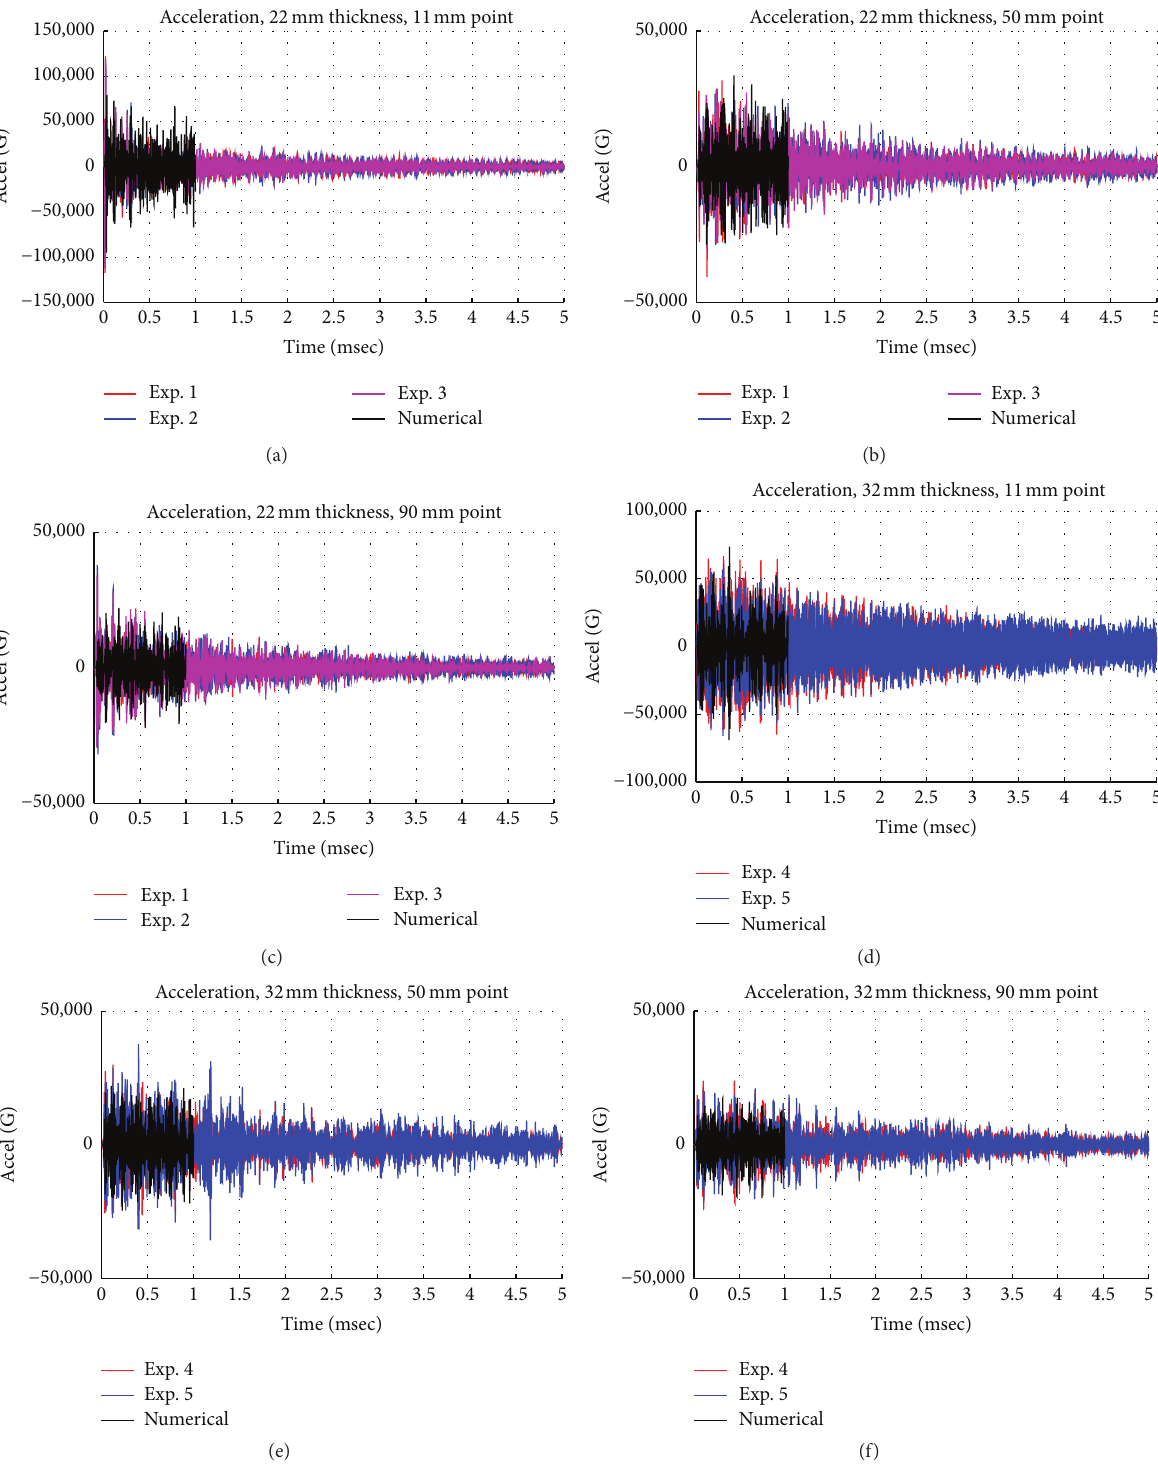
Figure 11: Comparison of acceleration between the numerical analysis and the experiments: (a) 11mm point at a 22mm thickness circular plate, (b) 50 mm point at a 22 mm thickness circular plate, (c) 90 mm point at a 22 mm thickness circular plate, (d) 11mm point at a 32 mm thickness circular plate, (e) 50 mm point at a 32 mm thickness circular plate, and (f) 90mm point at a 32 mm thickness circular